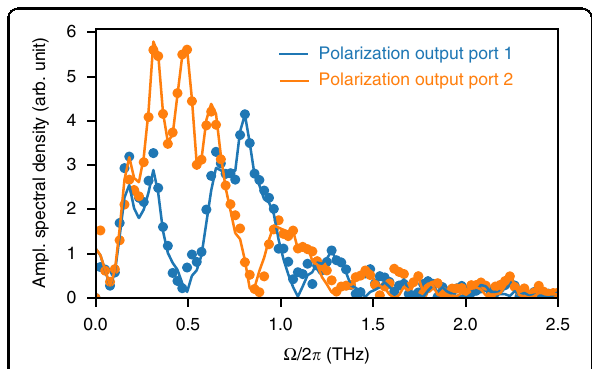
Fig. 4 Fit providing the reconstruction parameter B from a single-shot recording. Dots: Fourier spectra j ~ Y 1 ; 2 ð Ω Þj of experimental data before reconstruction. Lines: spectra j ~ Y retr computed from the retrieved input. ~ Y retr using B as a free parameter. Note the presence of interleaved zeros, which play a key role in the retrieval approach. Same data and color codes as for Fig. 3c,